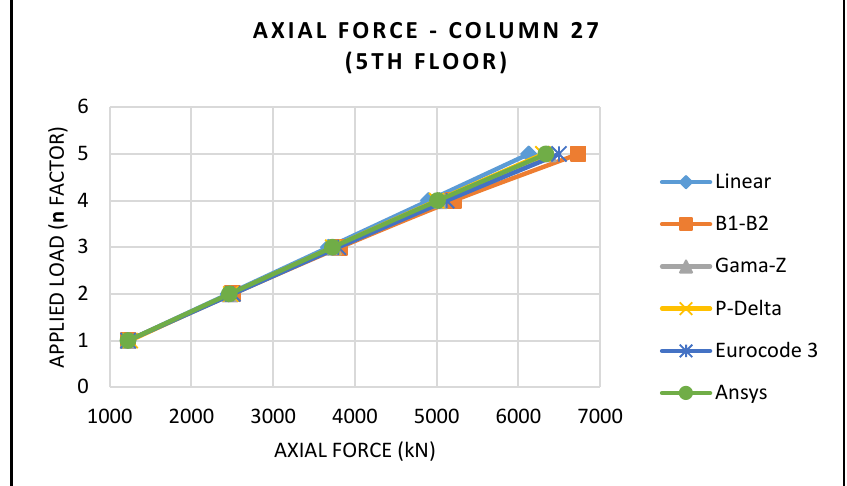
Figure 11 - Load - axial force relationship for column 27. Source: Authors (2020).